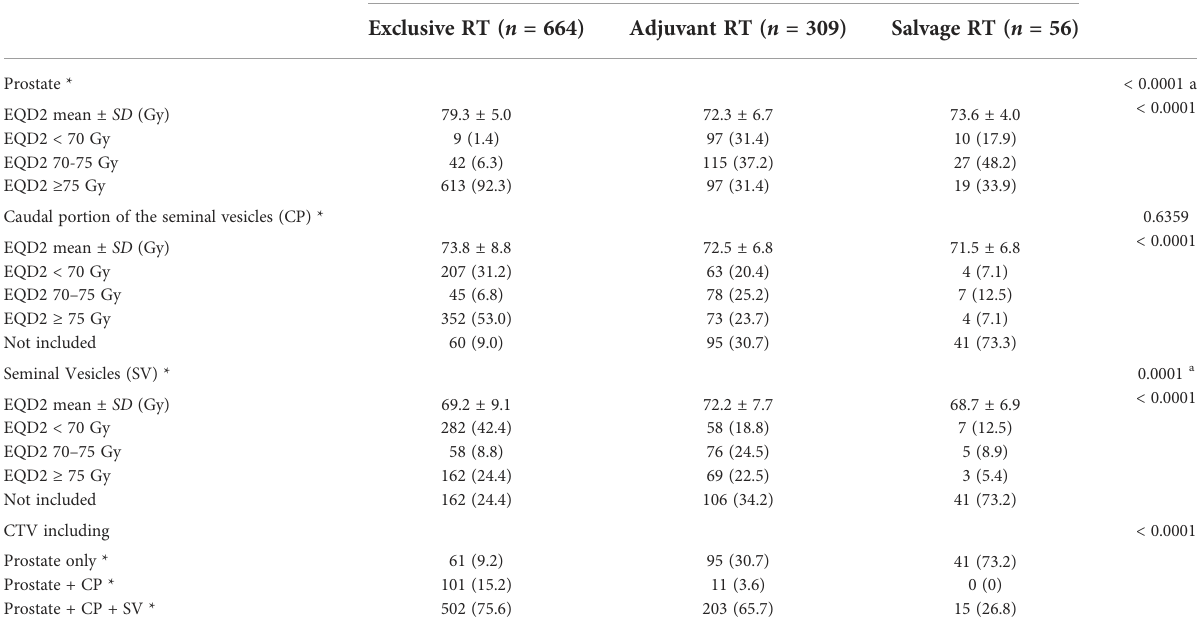
TABLE 3 Radiotherapy dose and